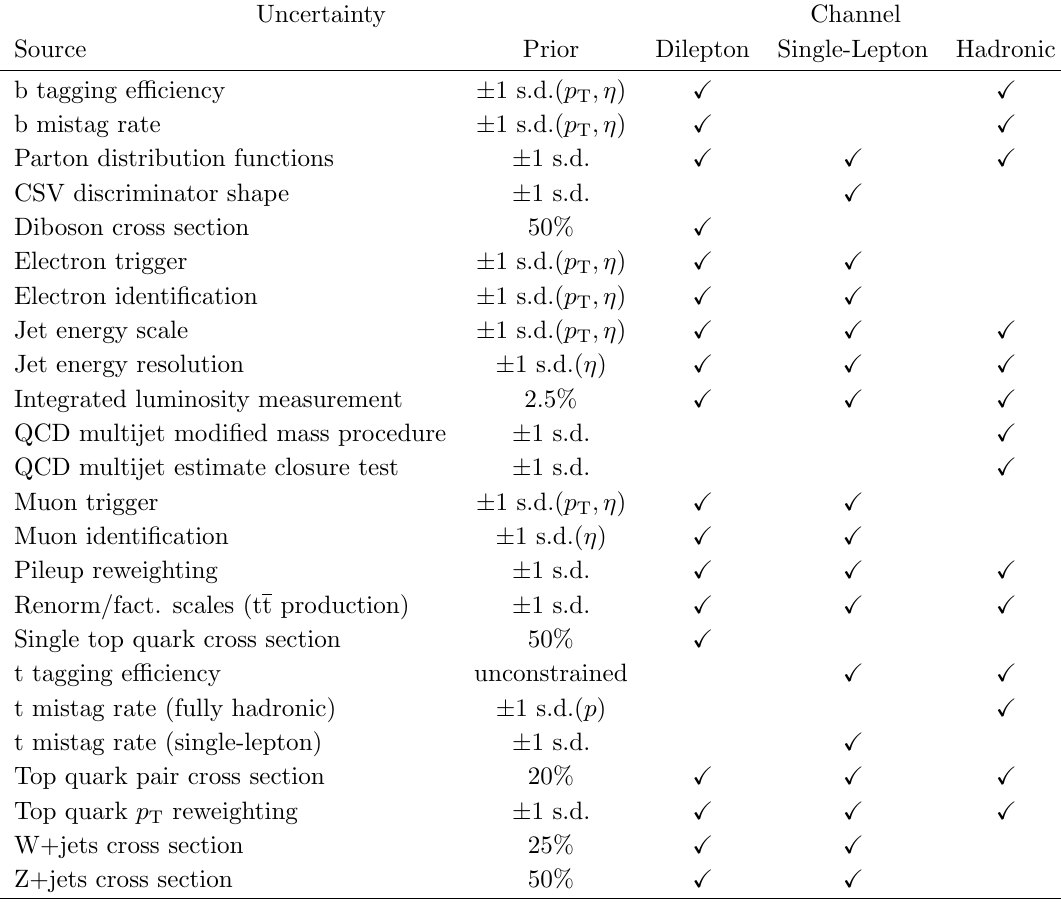
Table 1 . Sources of systematic uncertainty that a(cid:11)ect the m and S T distributions in each analysis tt channel. For uncertainty sources that apply to multiple channels, the corresponding nuisance parameter is fully correlated across these channels if the symbol X appears in the same row. For normalization uncertainties, the size of the e(cid:11)ect on the prior distribution is indicated. Shape uncertainties have priors of (cid:6) 1 s.d., and the dependence on the kinematic quantities is